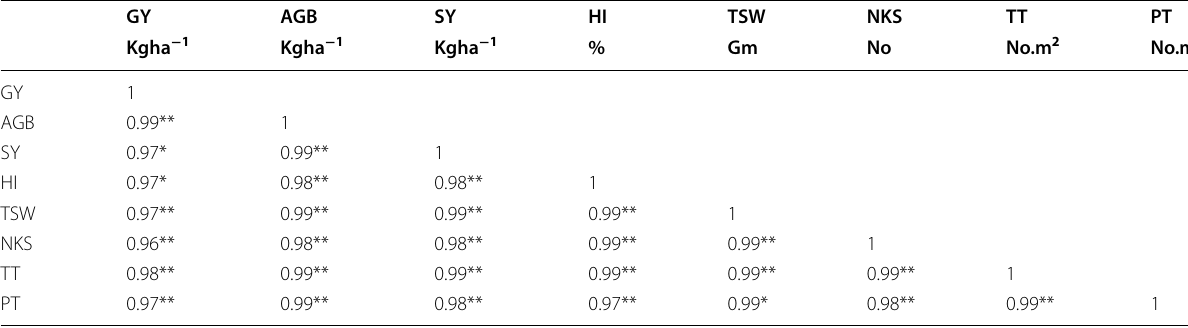
* and **, significant at 5% and 1% level of significance,